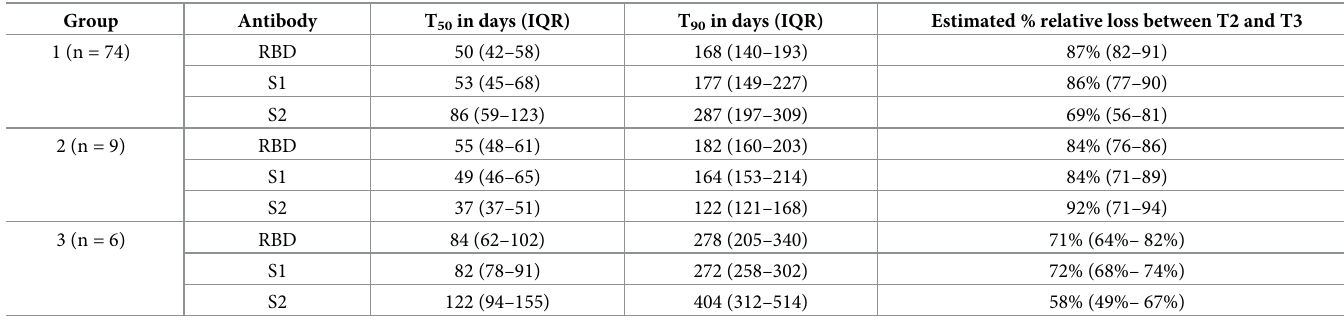
Table 4. Characteristic times for the waning antibodies.